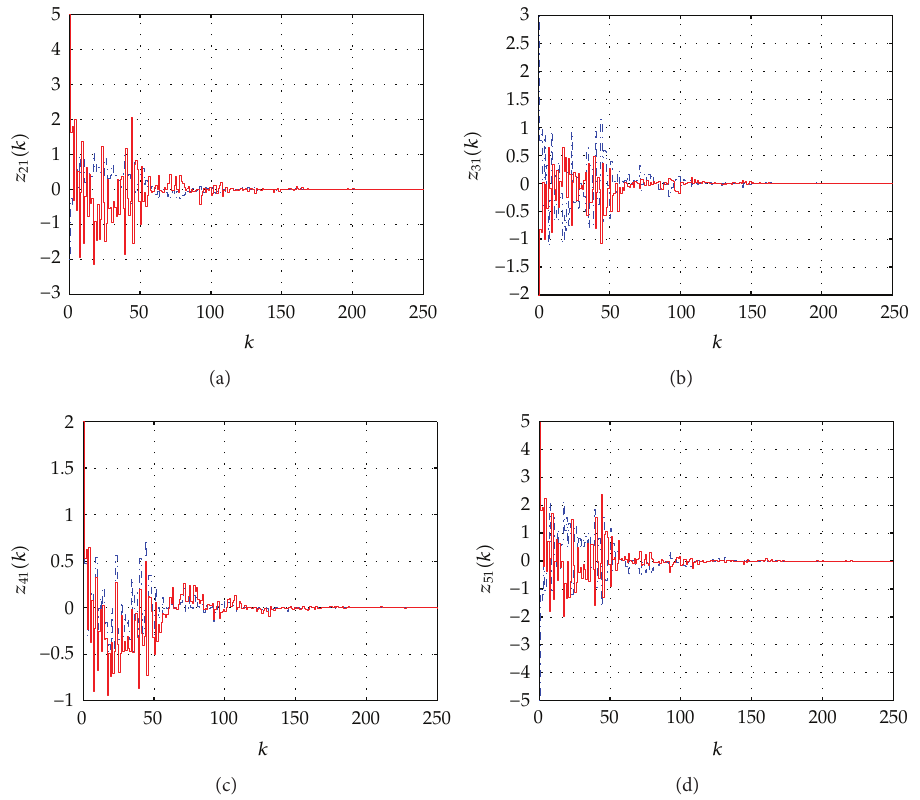
Figure 5: Synchronization errors trajectories with C1-2 (Example